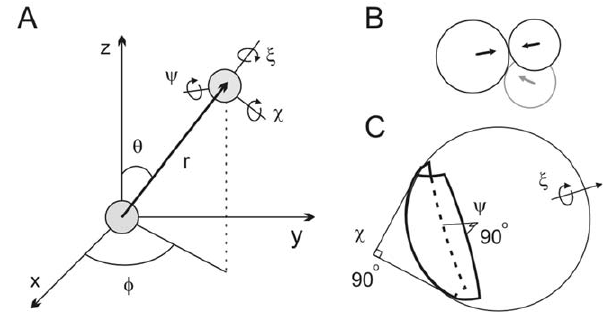
Figure 1. Illustration of the conformational search used in this work. (A) Definition of the search space in the spherical coordinates. Proteins’ CMs are shown as grey spheres, one of which is at the origin of the coordinate system. The moving protein (typically Cc) possesses three translational ( h , Q , r ) and three rotational ( x , y , j ) degrees of freedom. For the definition of the rotational axes see text. (B, C) Conformational search in the reduced rotational space. (B) Cc in the starting structure (black circles) is rotated to obtain the shortest separation between the ET cofactors (arrows). This ensures the frontal orientation of the Cc heme during subsequent h and Q rotations (grey circle). (C) The reduced rotational space 2 45 u # x , y # 45 u traced by a point on the surface of a sphere (bold shape). Location of the other rotation axis, j , is indicated.